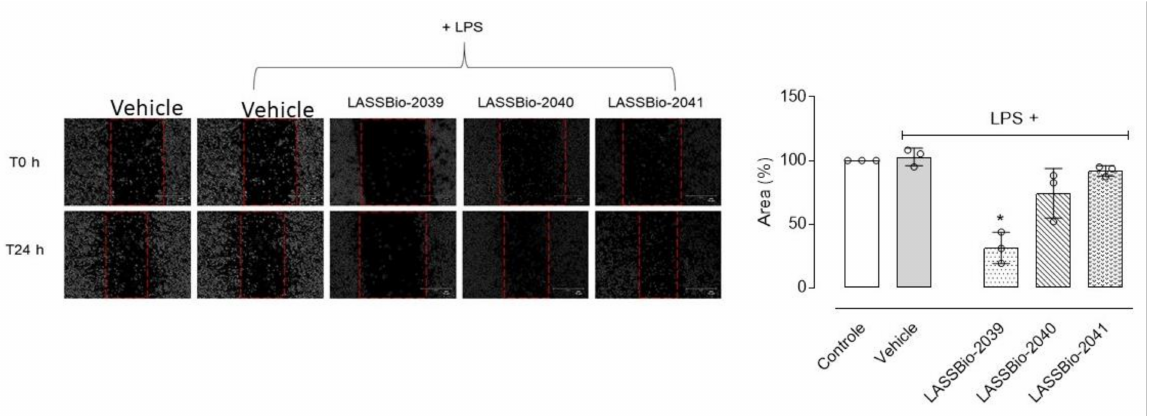
Figure 11. Effect of LASSBios in cell migration in vitro. J774.A1 cells were plated, and a wound area done. Cells were incubated with vehicle or LASSBios (10 µ M) 15 min before lipopolysaccharide (LPS, 1 µ g/mL) and after 24 h the area in each well was measured with the aid of ImageJ software (version 1.8.0.172, National Institute of Health, USA). Photos in the left are representative of 4 independent experiments and were obtained in a phase contrast microscope (EvosM500, ThermoFisher, Waltham, MA, USA), in 10 × objective. Bars corresponds to 10 µ m. In the right is the graph with data obtained after four different experiments. Results are expressed as media ± SD ( n = 4). Statistical significance was calculated in GraphPad Prism 8.0 (San Diego, CA, USA) using analyses of variance (ANOVA) followed by Tukey post-test with p < 0.01 (*) when comparing LPS-activated cells treated with LASSBios and LPS-activated cells treated with